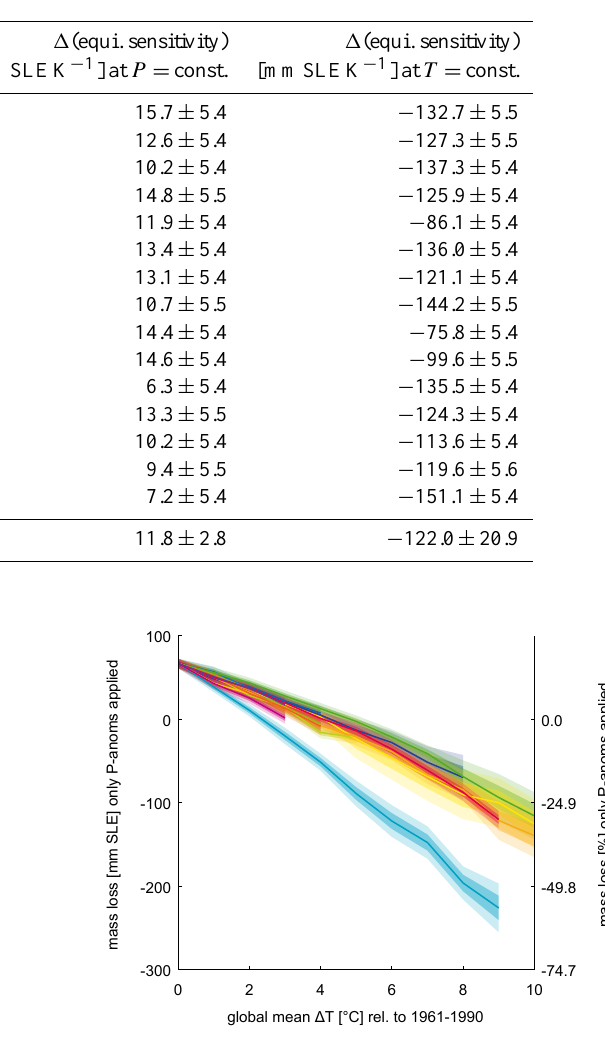
Fig. 4. Equilibrium mass loss (negative numbers imply mass gain) of glaciers when temperature anomalies are ignored, and only pre- cipitation anomalies associated with the temperature anomalies are applied. Dark (light) shading indicates one (two) standard errors. Colors as in Fig.